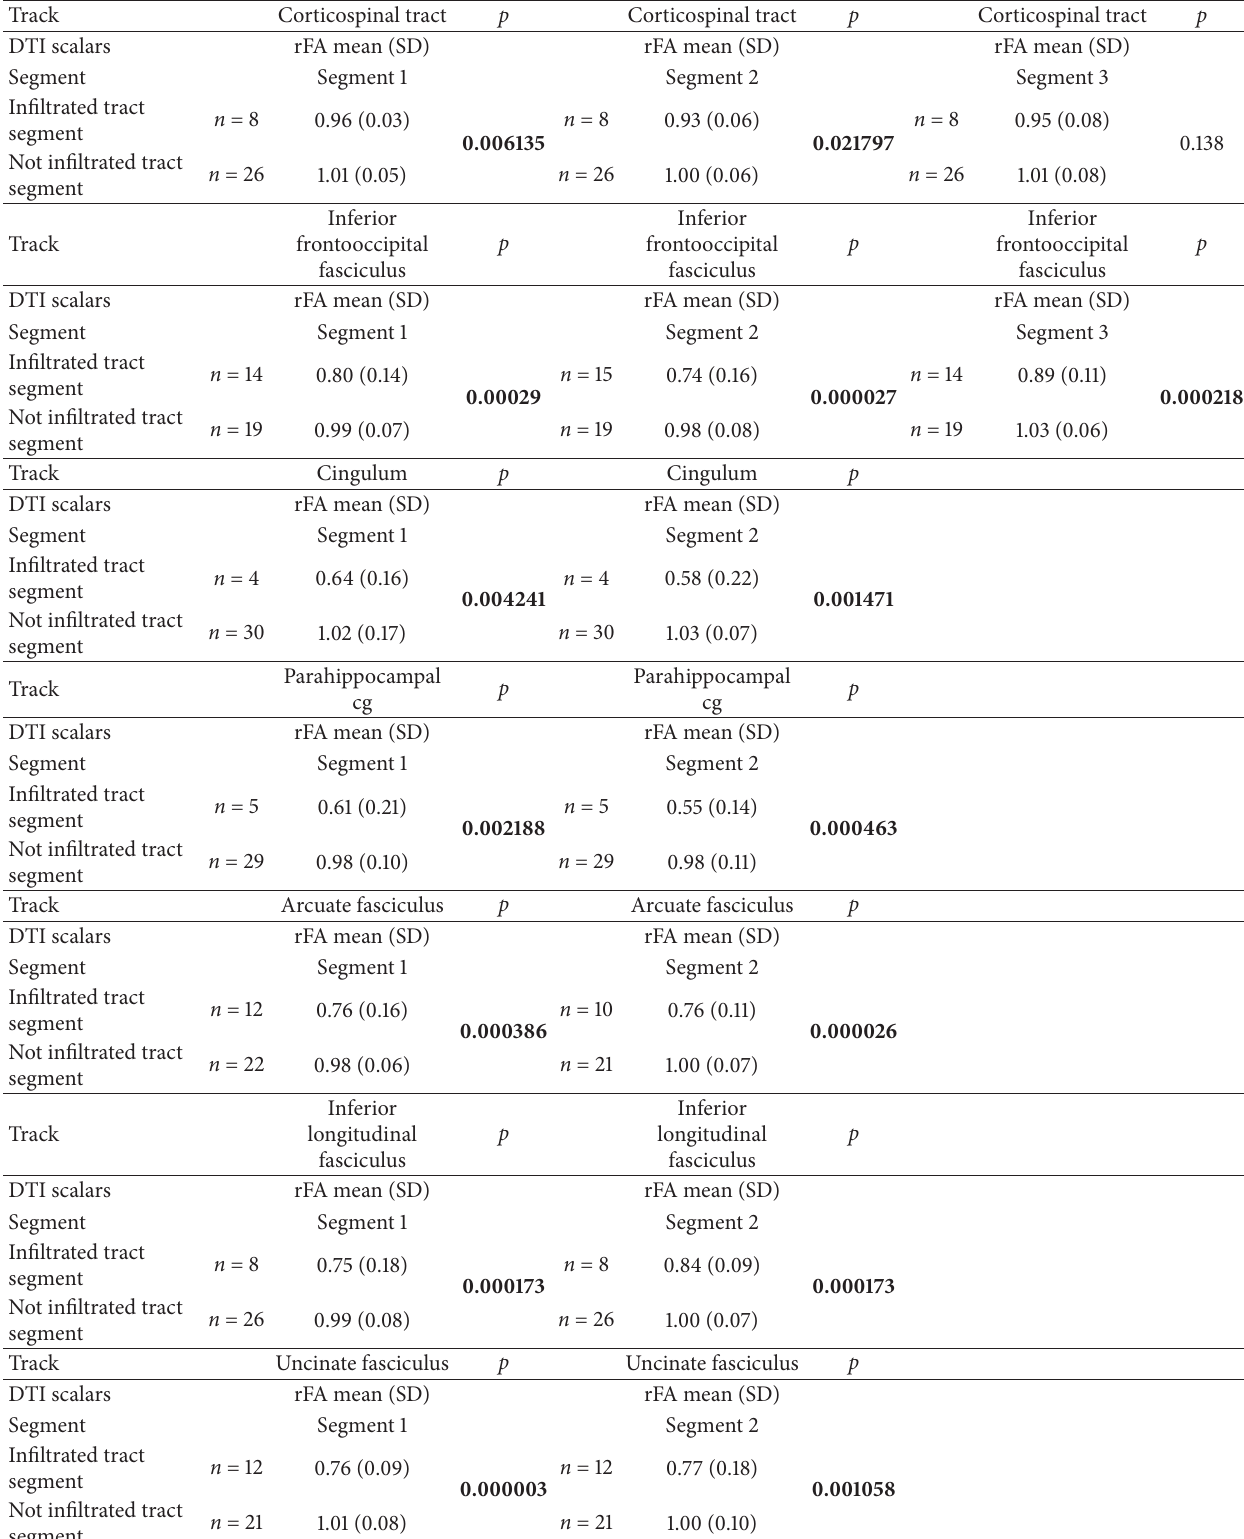
Table 2: Results from tractography, fractional